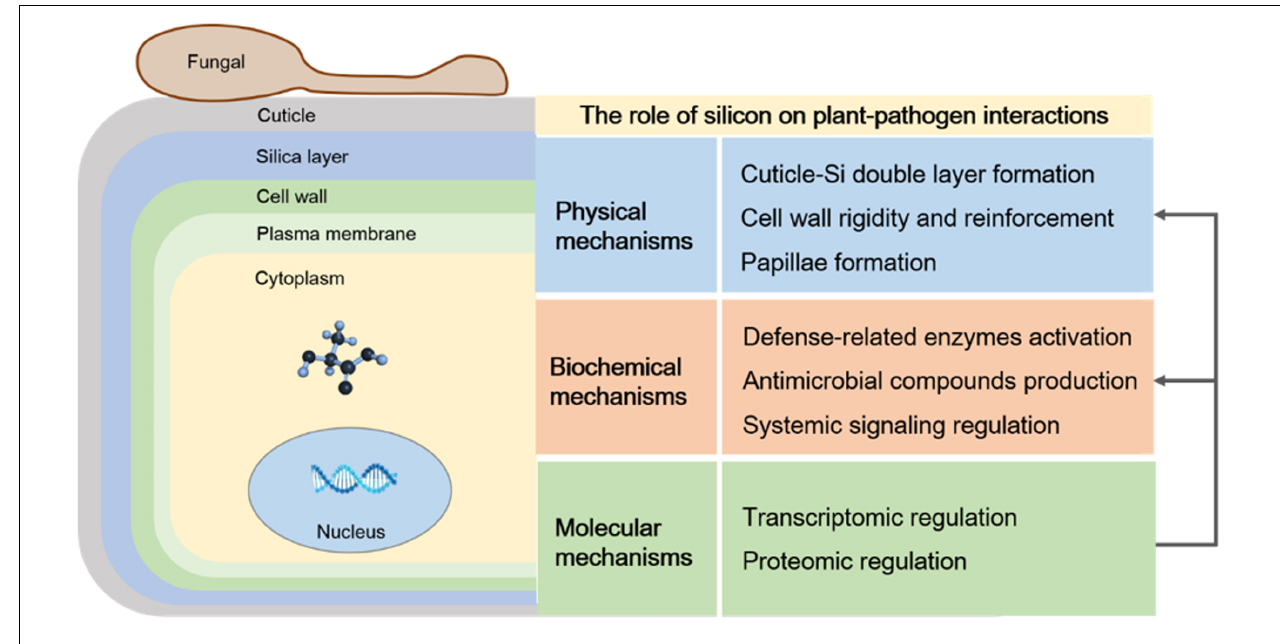
FIGURE 4 | The role of silicon (Si) on plant–pathogen interactions. Si mediated plant defense responses were classified as physical, biochemical and molecular mechanisms. Physical mechanisms involved in cell wall reinforcement and papillae deposition, biochemical mechanisms were attributed to activating defense-related enzymes, stimulating antimicrobial compounds production as well as regulating the complex network of signals pathways, and the molecular mechanisms mainly contained the regulation of genes and protein related to defense responses.